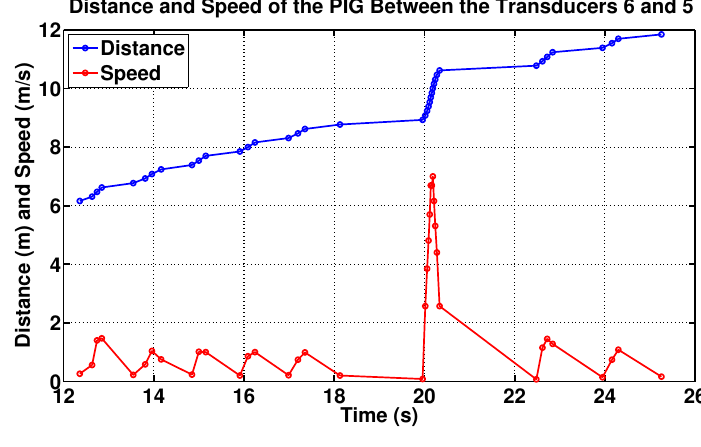
Figure 14. Speed PIG between the transducers 6 and 5, according the odometer. Source: By